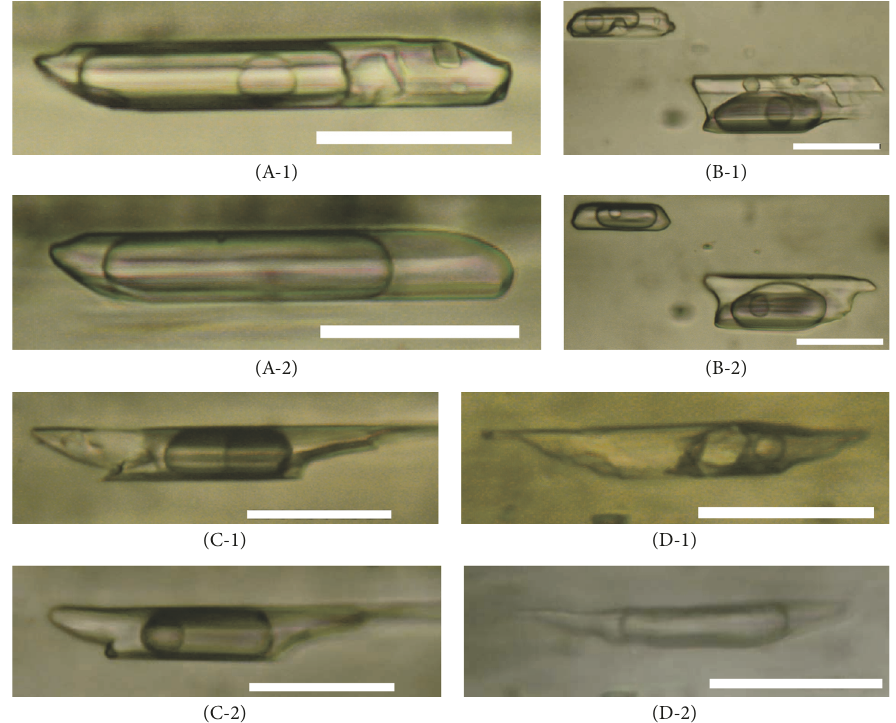
Figure 10: Photomicrographs of CIs in spodumene from the Jiajika deposit at room temperature before heating (A-1, B-1, C-1, and D-1) and after the homogenization experiments (A-2, B-2, C-2, and D-2). Note that, after the homogenization experiments, the original daughter minerals failed to nucleate and the corners of the CIs became rounded with slight decreases in the volumes of the inclusions. The length of the scale bar is 10 𝜇